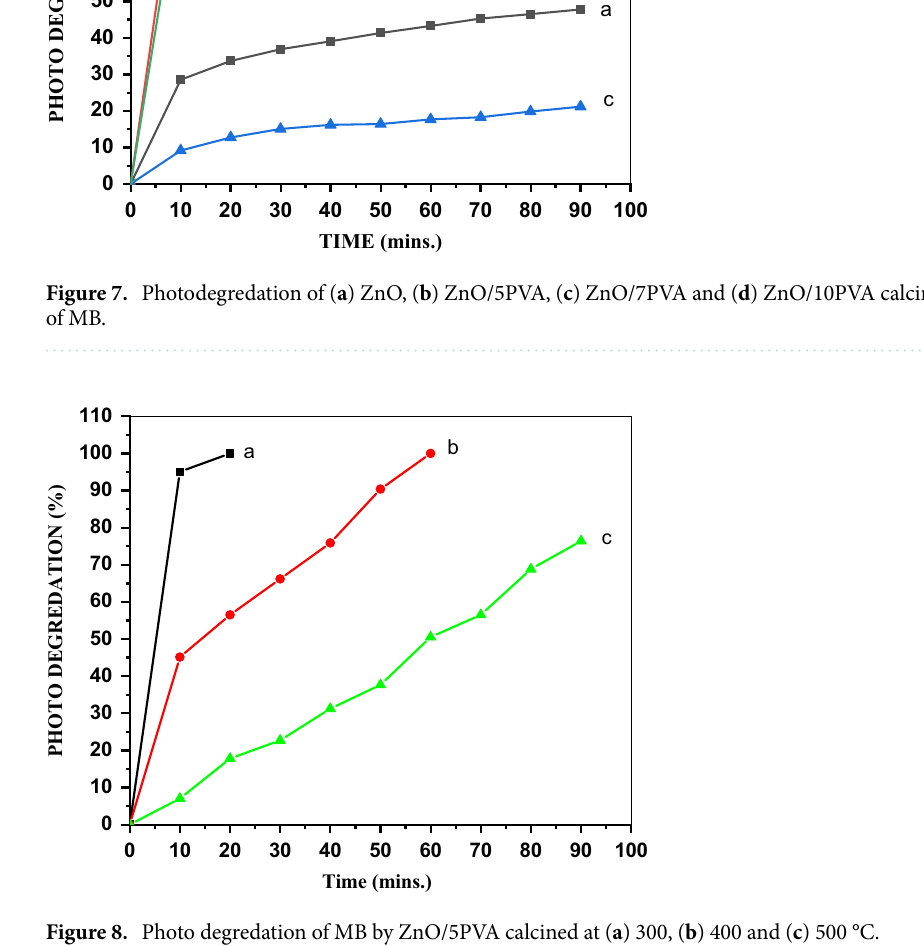
Figure 8. Photo degredation of MB by ZnO/5PVA calcined at ( a ) 300, ( b ) 400 and ( c ) 500